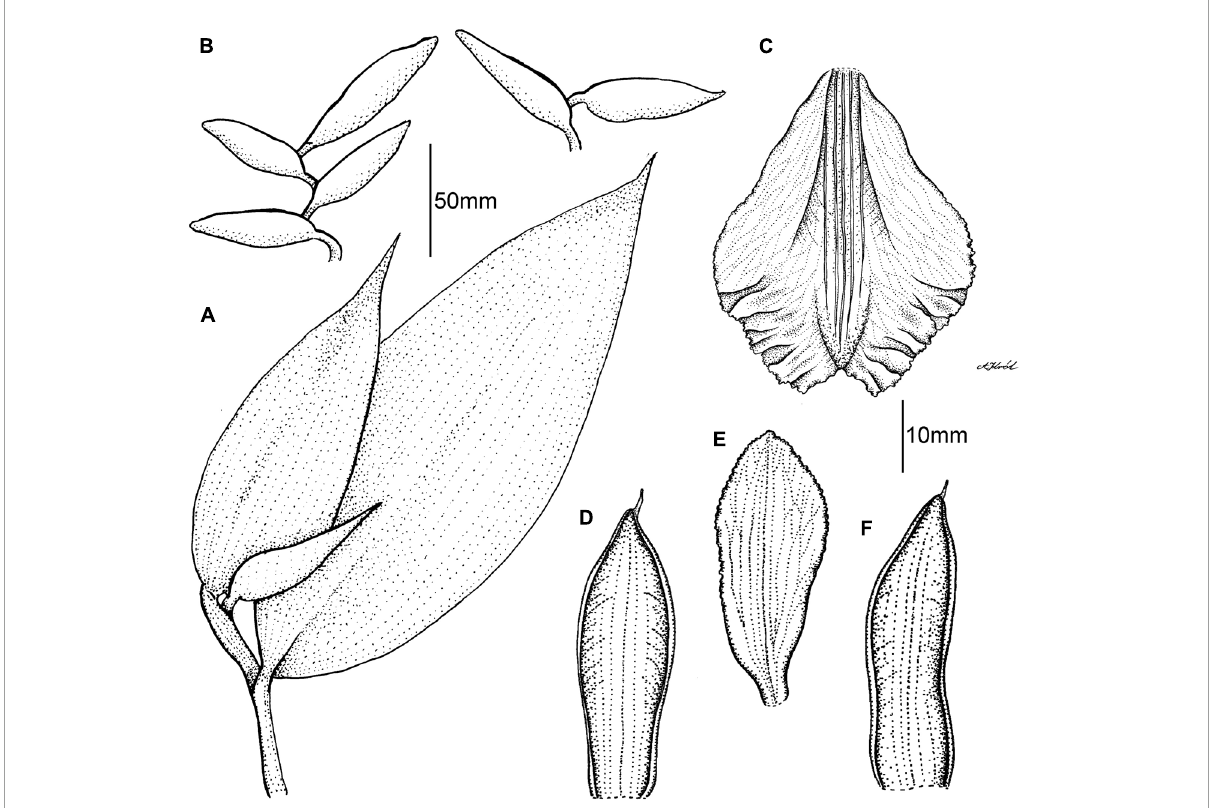
FIGURE8 Sobralia gloriosa Rchb. f. (A) apical part of stem, (B) fragments of the inflorescence, (C) lip, (D) dorsal sepal, (E) petal, and (F) lateral sepal [drawn by P. Baranow (A,B) and A. Król (C–F) from the lectotype].